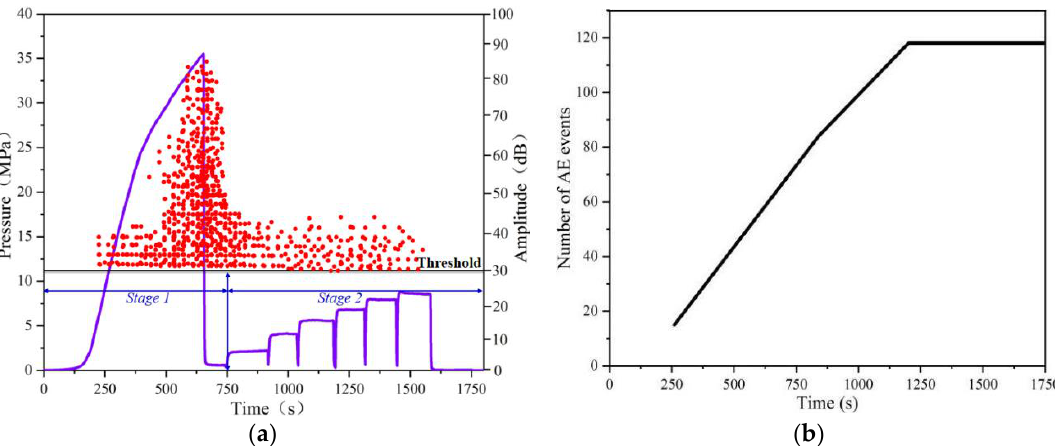
Figure 14. ( a ) AE amplitude recorded during the room-temperature fracturing test and ( b ) number of AE events over time of the MG-3 sample.